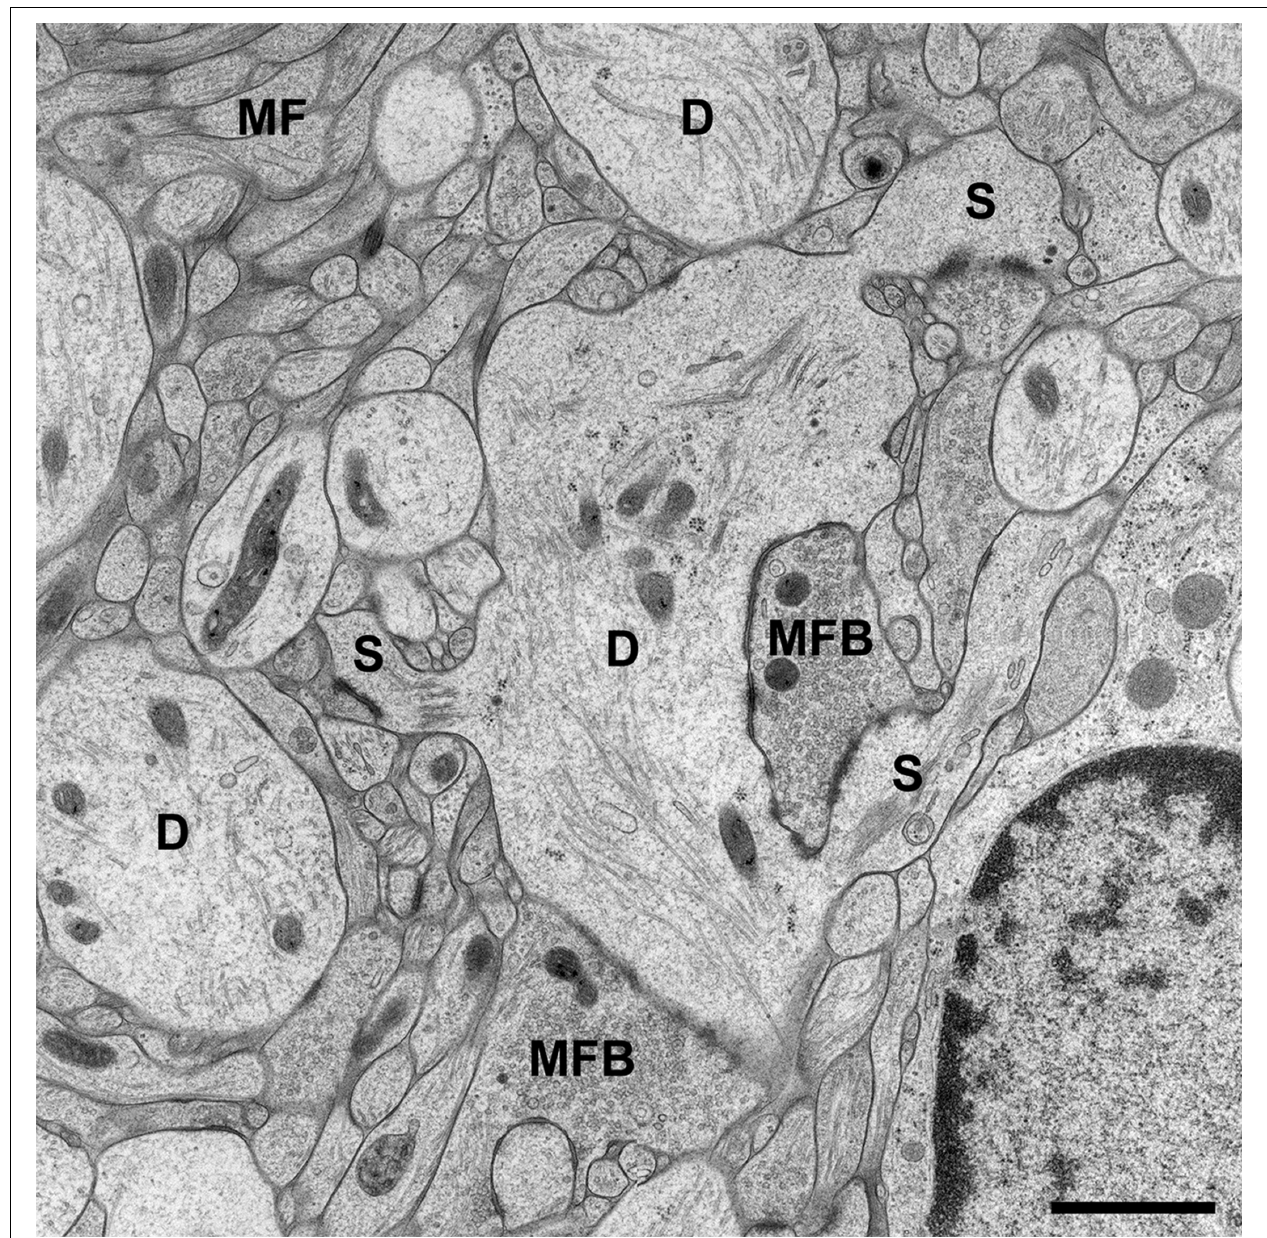
As known from many studies in perfusion-fixed material, the stratum lucidum mainly contains the thin unmyelinated axons of the mossy fibers (MF) and their giant boutons (mossy fiber bouton, MFB). The postsynaptic elements, the proximal dendrites (D) of CA3 pyramidal cells, are located in between the bundles of mossy fibers and give rise to large complex spines (S) for the contact with MFBs. Scale bar: 1 μ